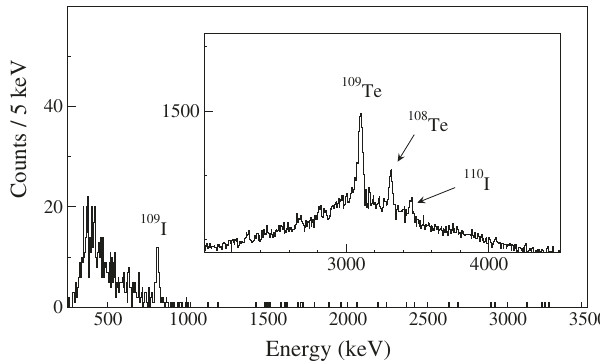
Fig. 4 Energy spectrum of punch-through-vetoed decay events. These events were measured in the DSSD within 300 μ s of an ion implantation into the same quasipixel at the beam energy of 370 MeV. The proton-decay peak of 109 I is indicated. The inset shows α -decay peaks from ground-state decays of 110 I and 108,109 Te obtained by applying a recoil-decay correlation time of 3 s.